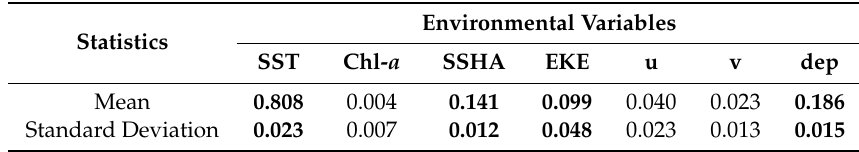
Table 3. Relative contribution of environmental variables averaged across all model simulations. The mean and standard deviation values of environmental factors with highest model contributions are highlighted in bold. The u and v correspond to geostrophic velocity components along the zonal and meridional planes, respectively. Statistics